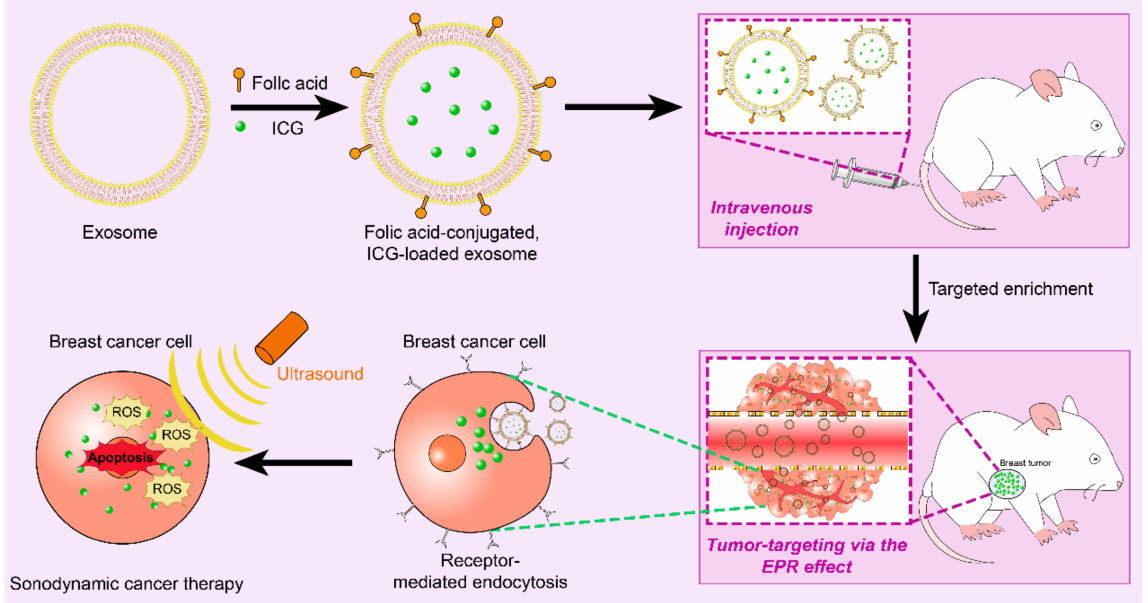
Figure 4. The exosomes were modified by FA and loaded with ultrasonic sensitizer ICG. After injection into the blood, they targeted the tumor tissue of mice and achieved local enrichment. Kill tumor tissue